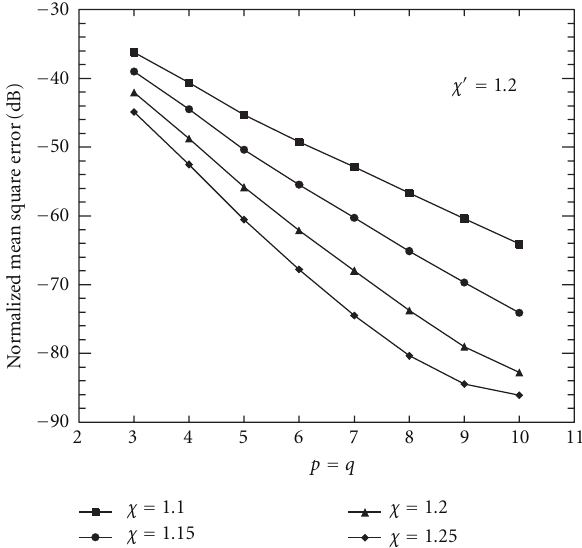
Figure 8: Normalized mean-square errors in the reconstruction of the voltage V (cid:2) .